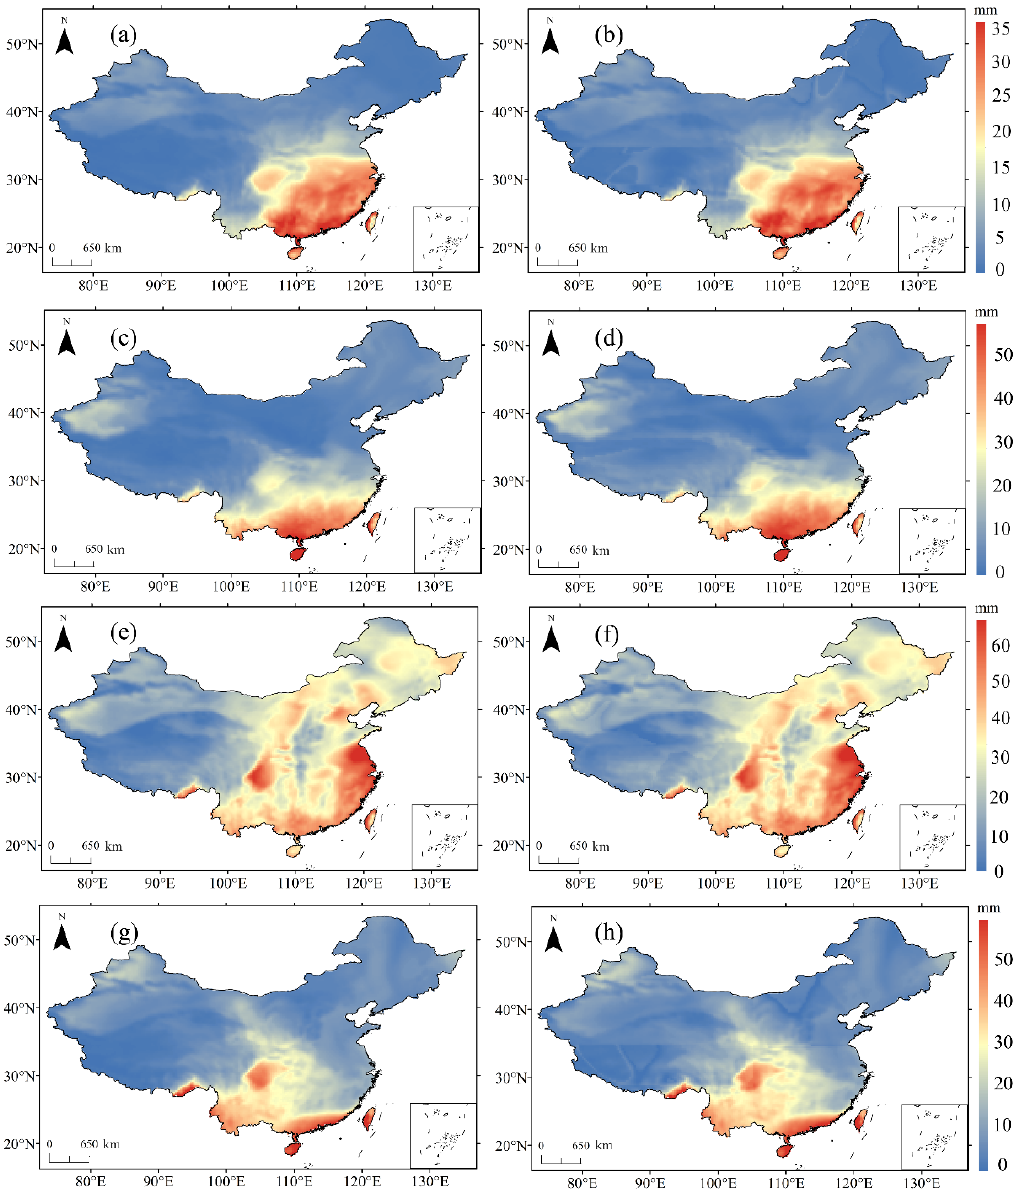
Figure 13. The distribution of PWV before ( a , c , e , h ) and after ( b , d , f , g ) calibration at 6:00 p.m. (UTC) on 23 January, 23 April, 29 August, and 23 October.